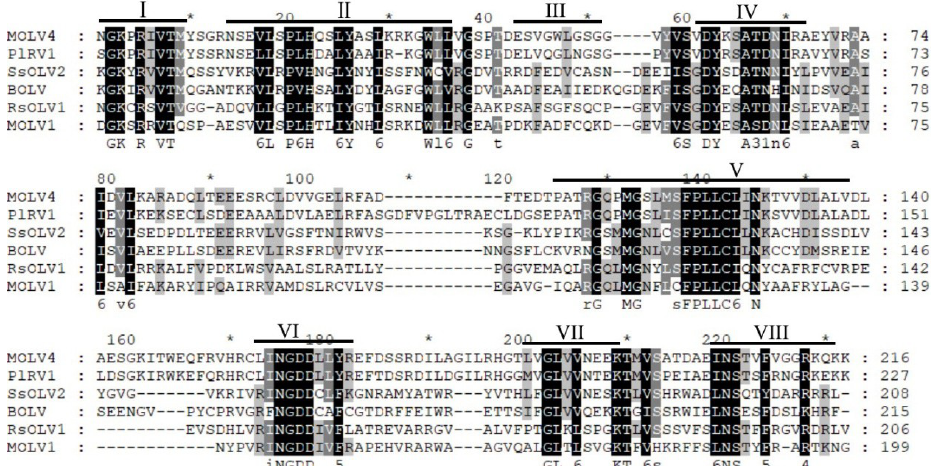
Figure 2. Multiple alignment of the amino acid sequences of RdRp encoded by MOLV4 and other related ourmia-like viruses. The conserved motifs in RdRp of the compared viruses are shown by roman numerals I to VIII. Abbreviations: PIRV1, Phomopsis longicolla RNA virus 1; SsOLV2, Sclerotinia sclerotiorum ourmia-like virus 2; BOLV, Botrytis ourmia-like virus; RsOLV1, Rhizoctonia solani ourmia-like virus 1; MOLV1, Magnaporthe oryzae ourmia-like virus 1. Identical residues are colour-highlighted with black shadow, and conserved and semi-conserved amino acid residues are colour-highlighted with gray shadow.